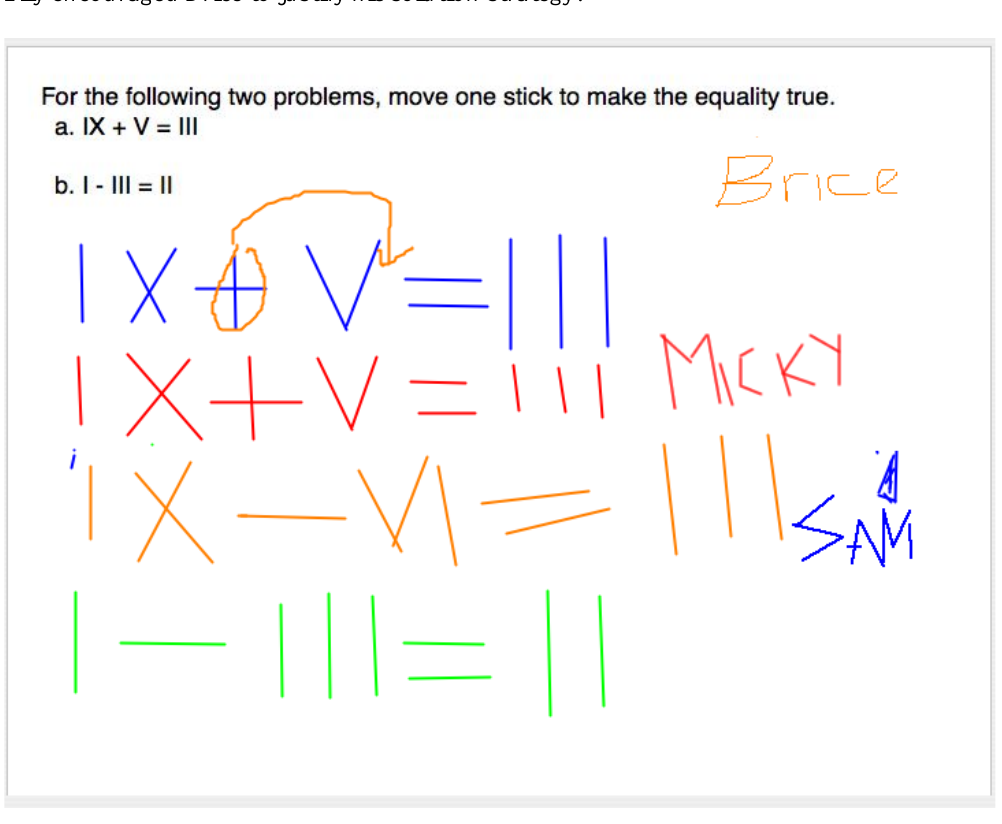
Figure 3 . Brice finds the